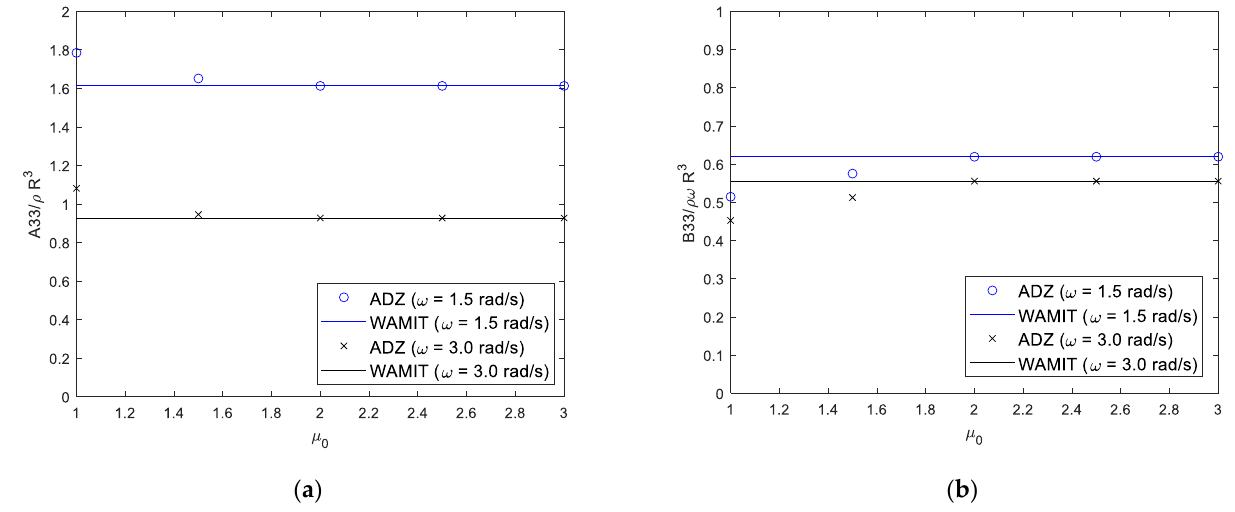
Figure 11. Convergence test on the artificial damping coefficients ( ω = 1.5 rad/s and ω = 3.0 rad/s): ( a ) nondimensional heave-added mass; ( b ) nondimensional heave radiation damping coefficient.